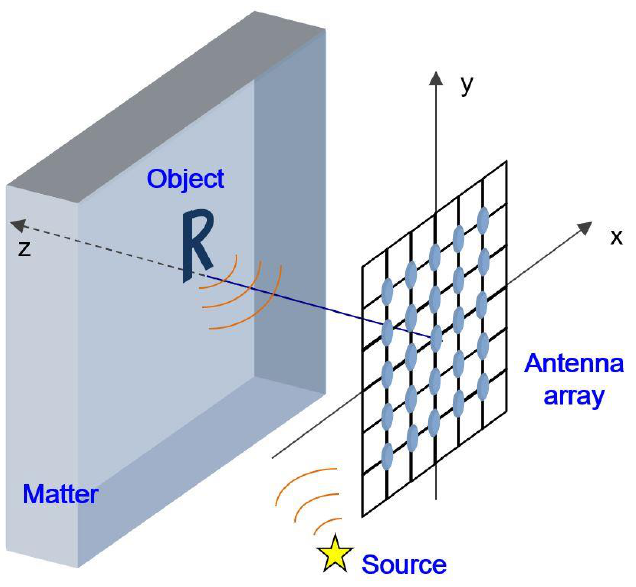
Figure 8. Schematic view of the experiment and HSR